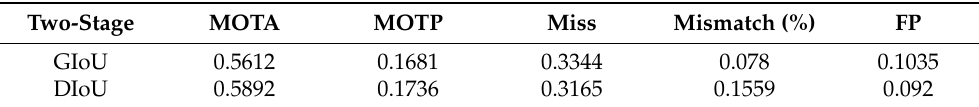
Table 4. Comparisons for 3D MOT two-stage association on vehicle class, Waymo Open Dataset validation set.